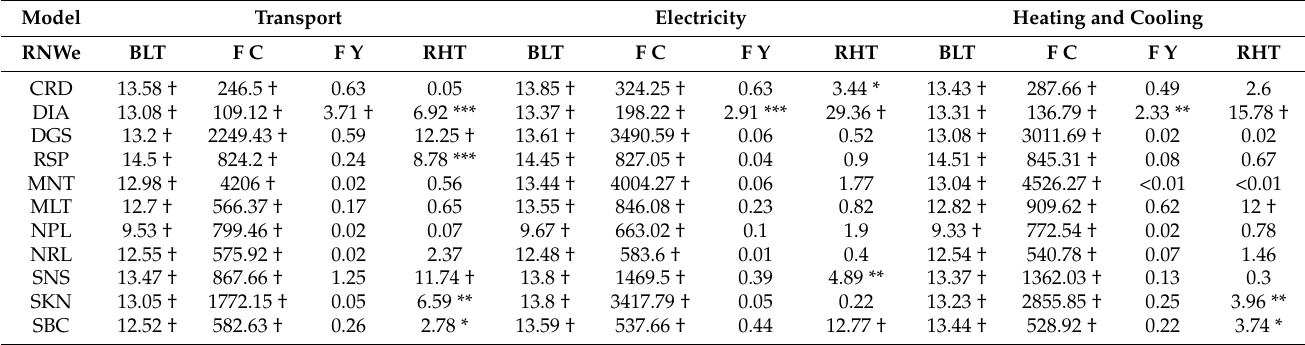
Table 3. Assumptions for the selection and application of panel regression